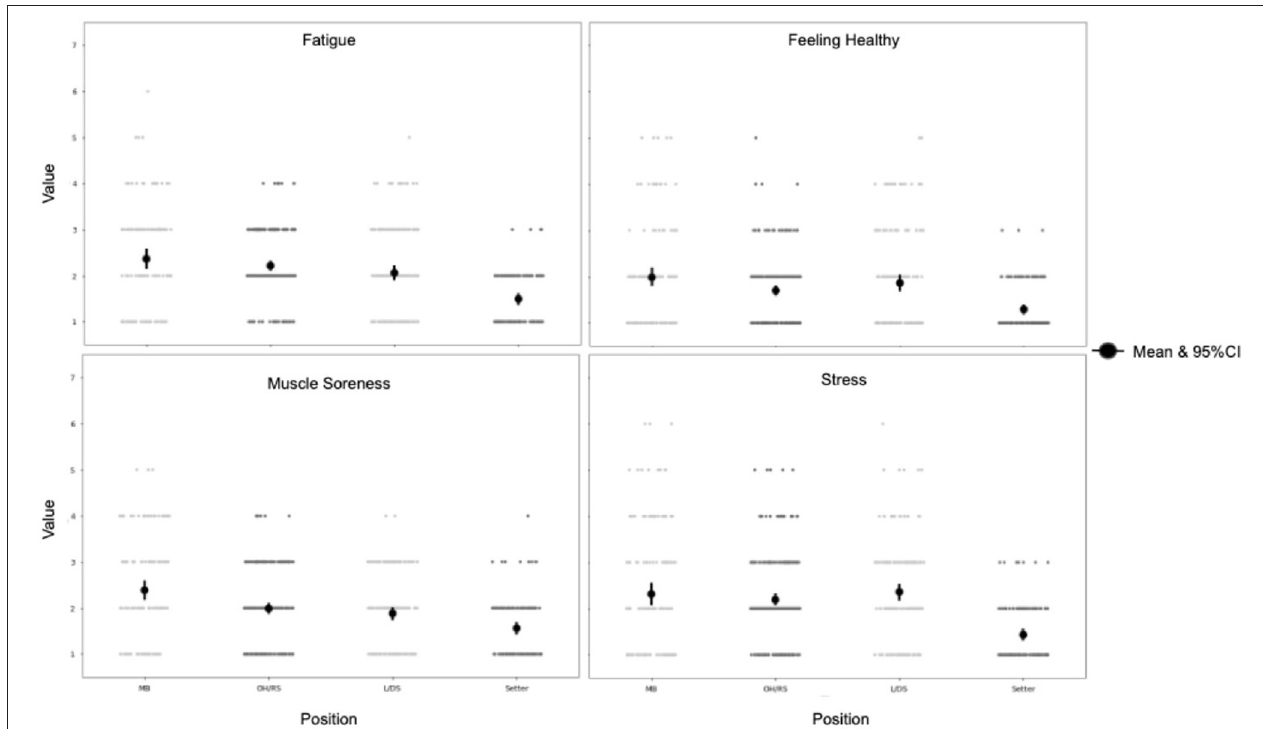
FIGURE 7 | Wellness measures by position. Each point on the graph represents an individual player-session. A value of 1 indicates increased wellness, whereas a value of 7 indicates decreased wellness. MB, middle blocker; OH/RS, outside hitter/right side hitter; L/DS, libero/defensive